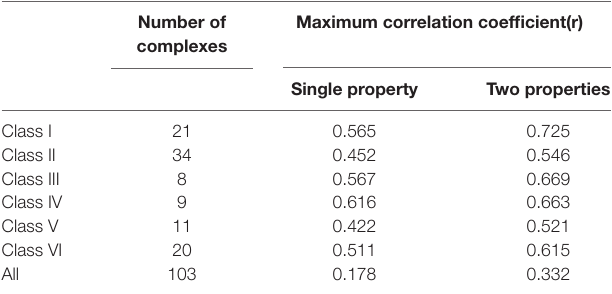
TABLE 2 | Performance of models built on the best one and two features for six classes of protein-RNA complexes. Number of Maximum correlation coefficient(r) complexes